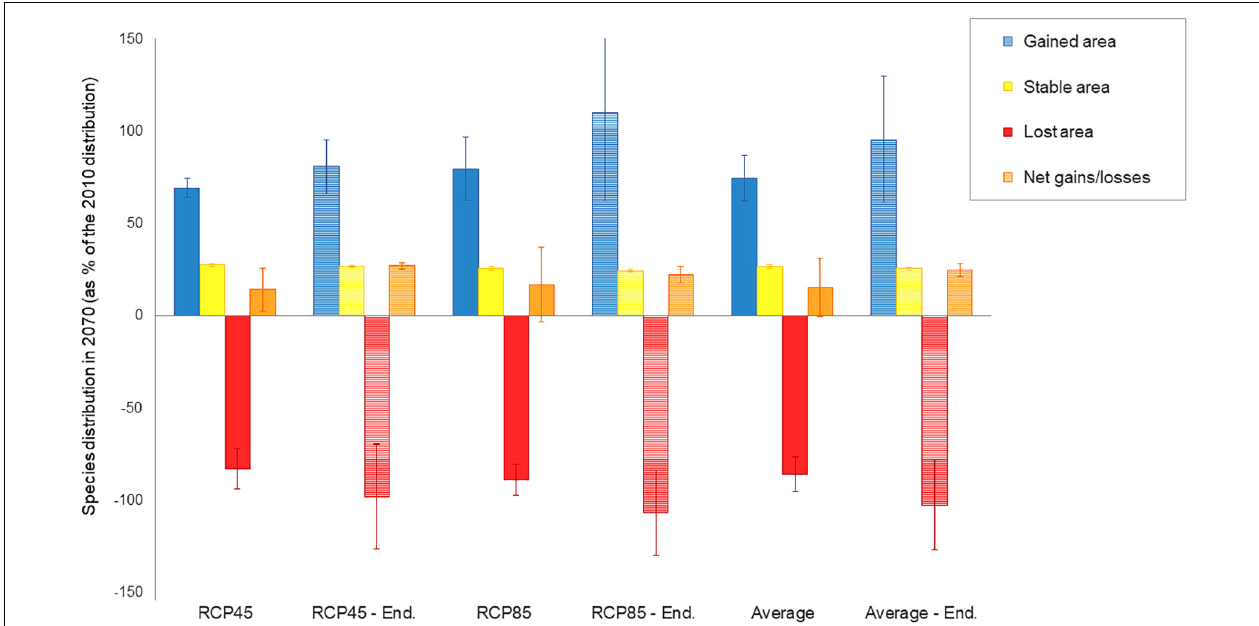
FIGURE 2 | Distribution changes expected for 664 páramo plant between 2010 and 2070 as: gained area, stable area, lost area and net area gain/loss. Net area gain/loss accounts for the area occupied by the species in 2070 (stable and gained area), as well as the area lost between 2010 and 2070. Changes are calculated based on cell classification of the 2070 raster relative to the 2010 raster and are hence expressed for the 2070 species distribution as a percentage of the 2010 distribution. They are given as mean responses over the 5 GCM for RCP45 (moderate scenario) and RCP85 (severe scenario) and on average. Values for endemics alone (247 species) figure in dashed colors per RCP and on